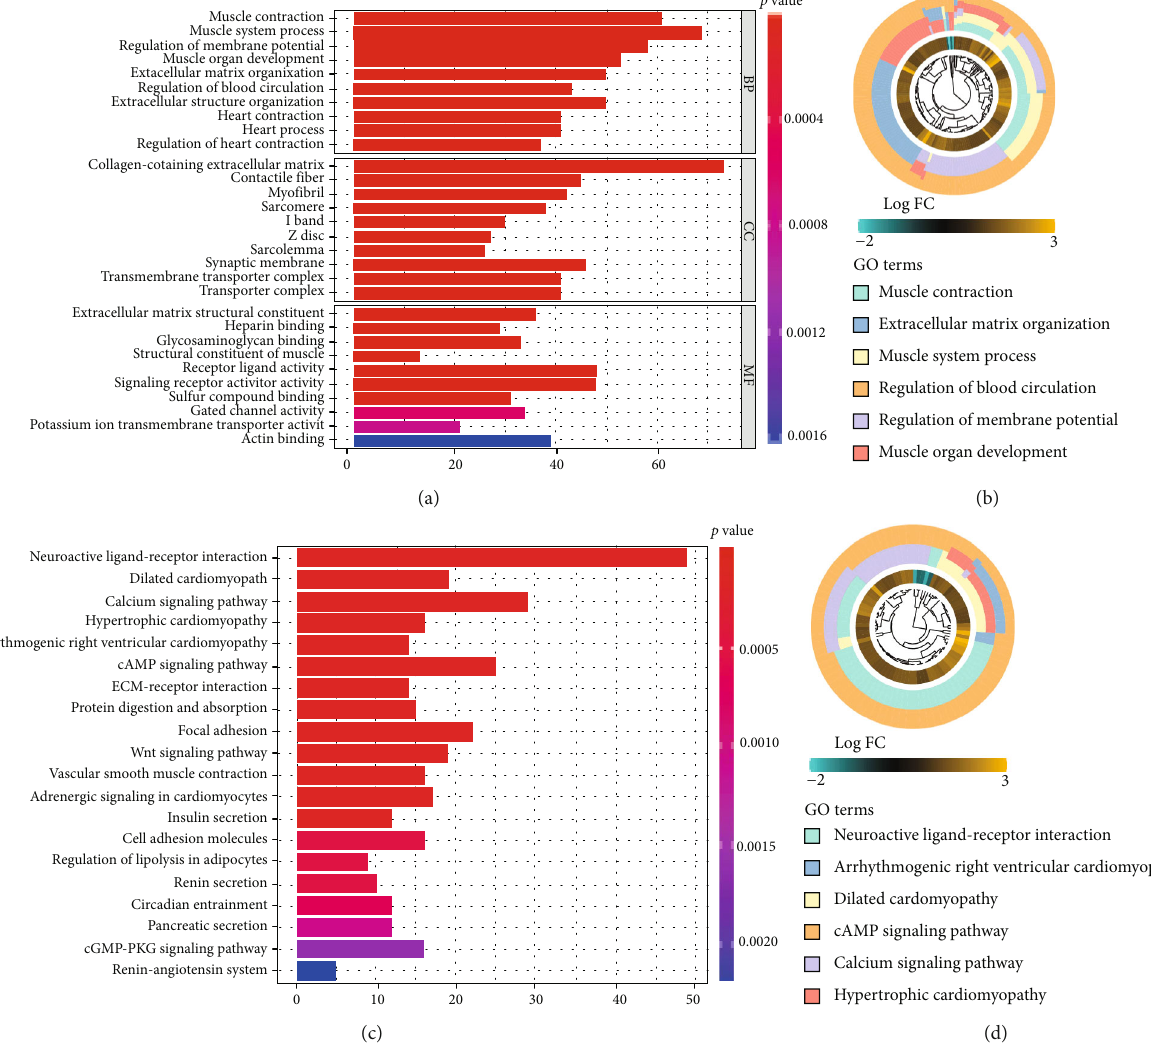
Figure 7: Gene enrichment analysis. (a, b) The GO functional enrichment analysis. Di ff erentially expressed genes were mainly related to transmembrane transport across the cell membrane and receptor exchange. (c, d) The KEGG pathway enrichment analysis. They were mainly enriched in the calcium signaling, cAMP signaling, ECM-receptor interaction, focal adhesion, and Wnt signaling